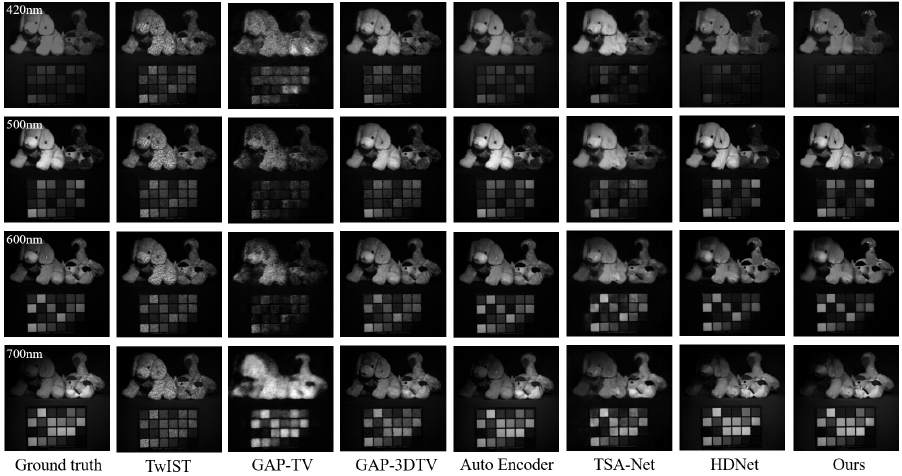
Figure 7. Reconstructed spectral images with a size of 256 × 256 from the KAIST dataset. We show the reconstructed results of four bands (wavelength: 420, 500, 600, and 700 nm) by different algorithms.